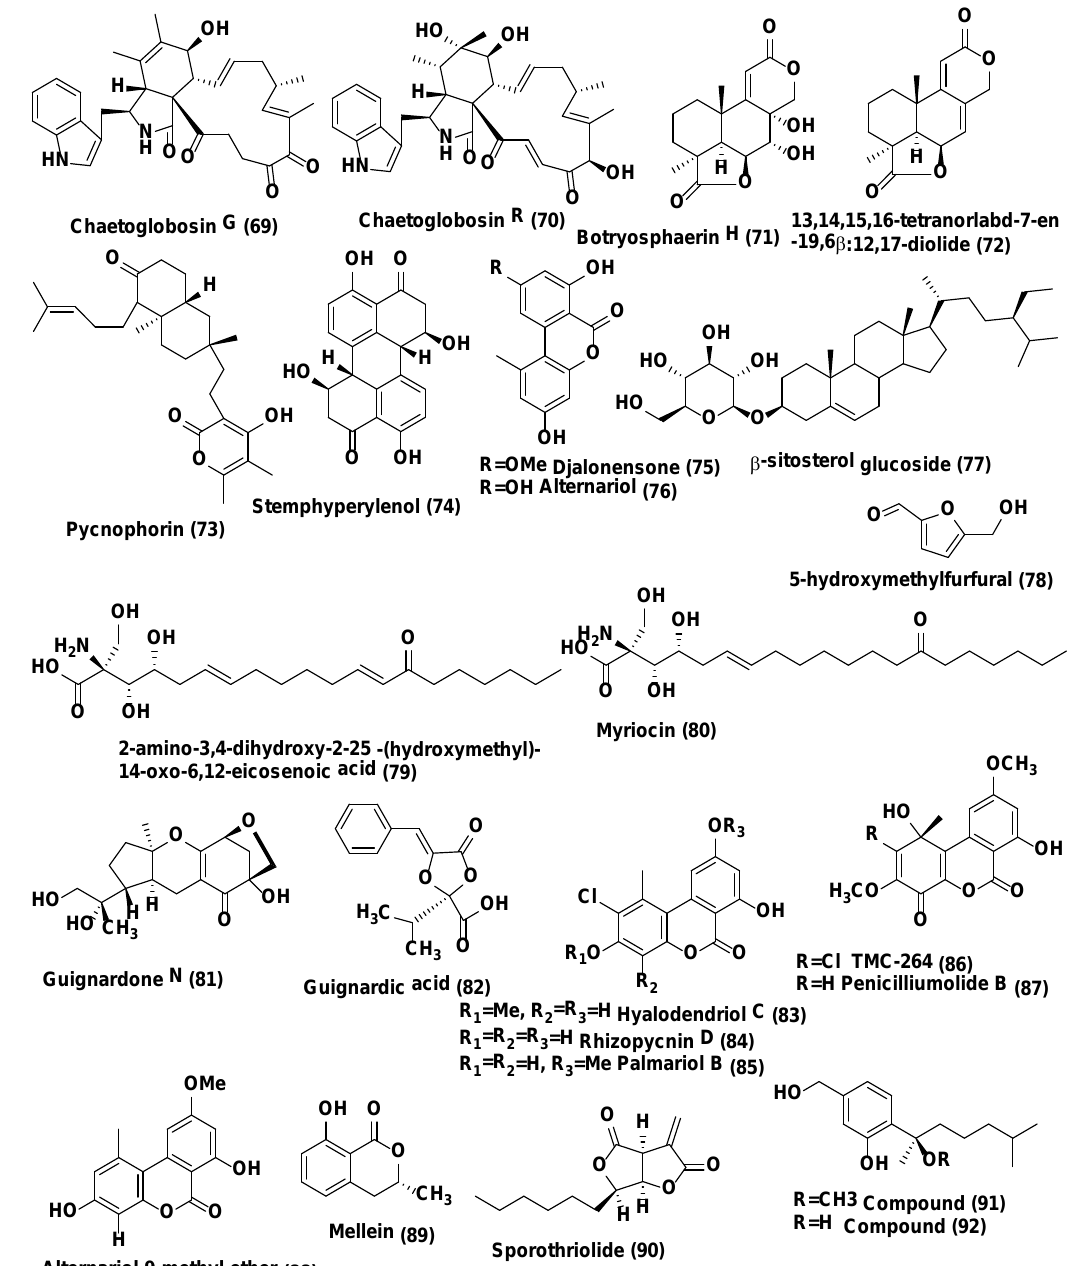
Figure 4. Structures of metabolites isolated from Ascomycetes ( 69 – 92 ).